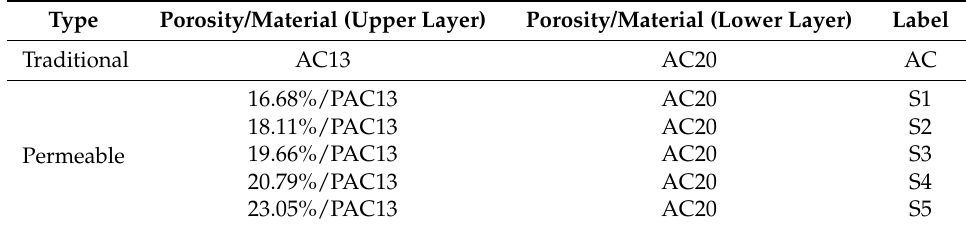
Table 7. Structure design of specimens.